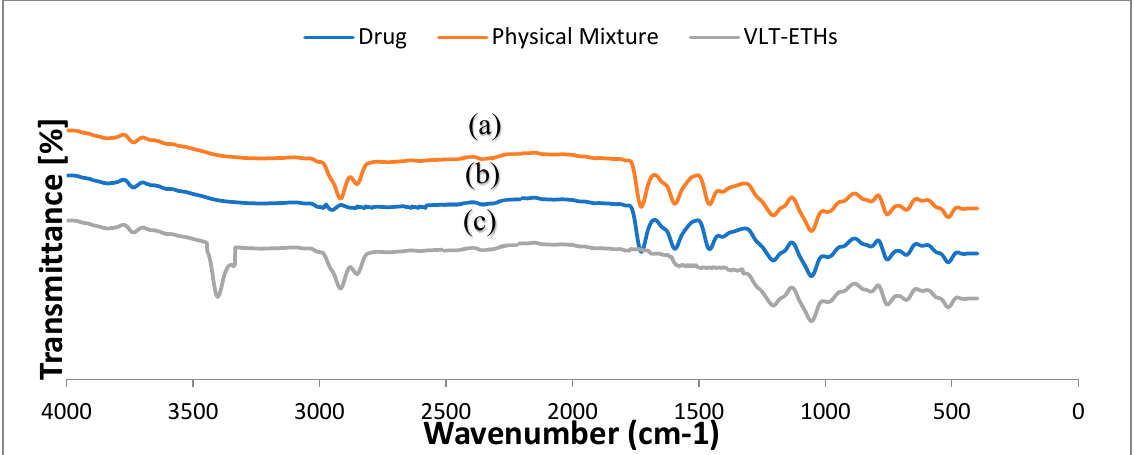
Figure 4. FTIR spectra of (a) physical mixture, (b) pure valsartan powder, and (c) optimized VLT-ETH formulation.